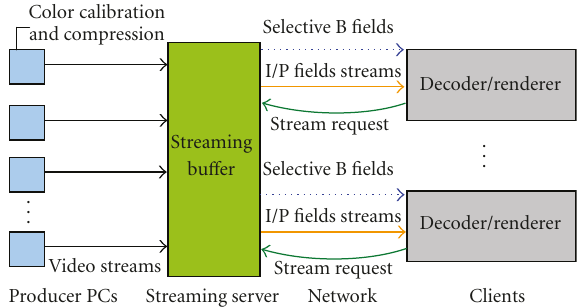
Figure 9: Block diagram of our streaming